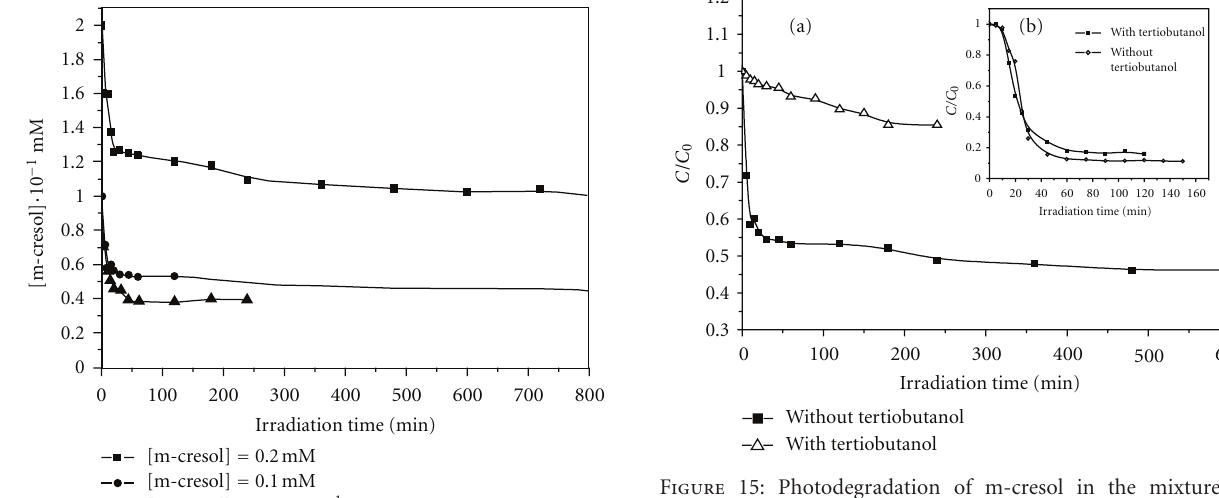
Figure 15: Photodegradation of m-cresol in the mixture m- cresol/Fe(III)-Cit (0.1mM, 0.3mM) upon irradiation at λ irradiation = 365 nm. (cid:8) with tertiobutanol, (cid:5) without tertiobutanol. Inset displays photodegradation of Fe(III)-Cit (0.3mM). ♦ with ter- tiobutanol, (cid:5) without